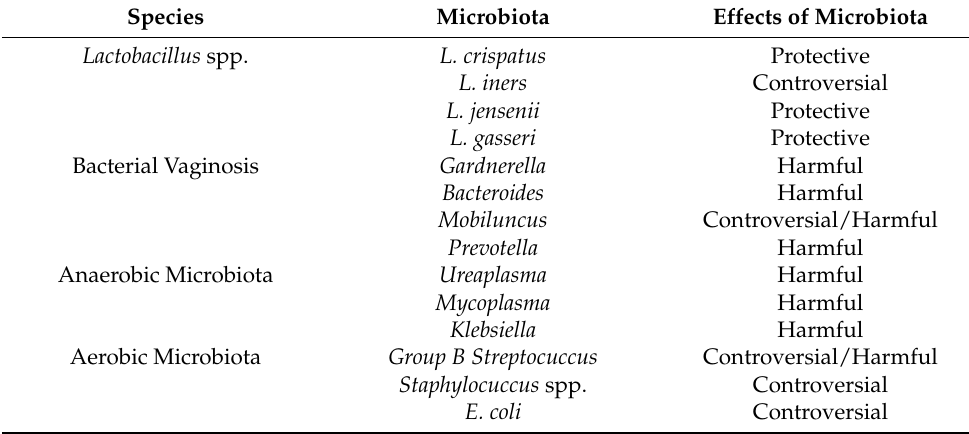
Table 2. Diversity of vaginal microbiota in pregnancy [31]. Species Microbiota Effects of Microbiota Lactobacillus